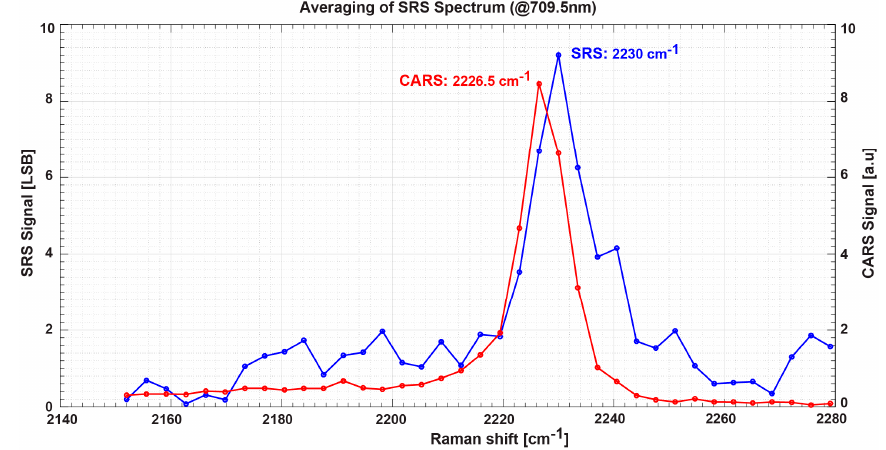
Figure 20. Benzonitrile Raman spectrum measured by coherent anti-stokes Raman spectroscopy (CARS) ( red ) and SRS ( blue ).